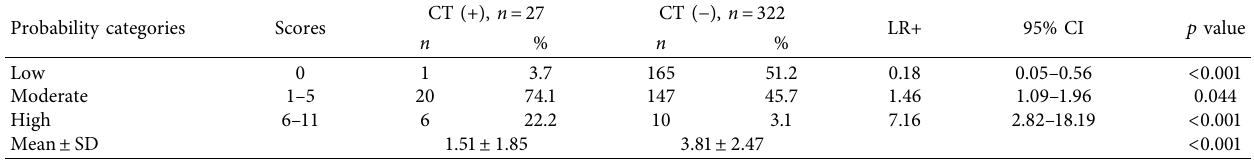
Table 3: Distribution of CT (+) versus CT ( − ) according to low, moderate, and high probability categories, LR+, and 95% CI. Probability